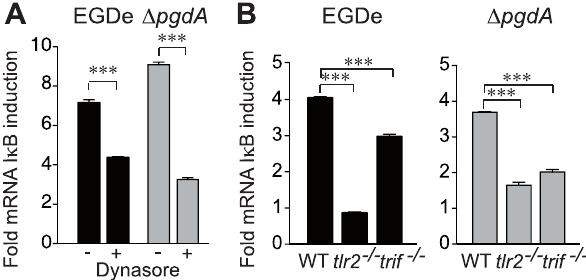
Figure 7. Bacterial internalization and NF- k B are required for TLR2 and TRIF-dependent IFN- b response in peritoneal mac- rophages. (A) PEM from WT C57BL/6J mice and pretreated with dynasore were infected with the parental EGDe strain (black bars) or the D pgdA mutant (grey bars). 4 h post-infection, I k B induction was measured by qRT-PCR. (B) PEM from WT C57BL/6J, tlr2 2 / 2 and trif 2 / 2 mice were infected with the parental EGDe strain (black bars) or the D pgdA mutant (grey bars). 4 h post-infection, mRNA was isolated and I k B induction was measured by qRT-PCR. Data are mean 6 SD (***, p , 0.0001, n